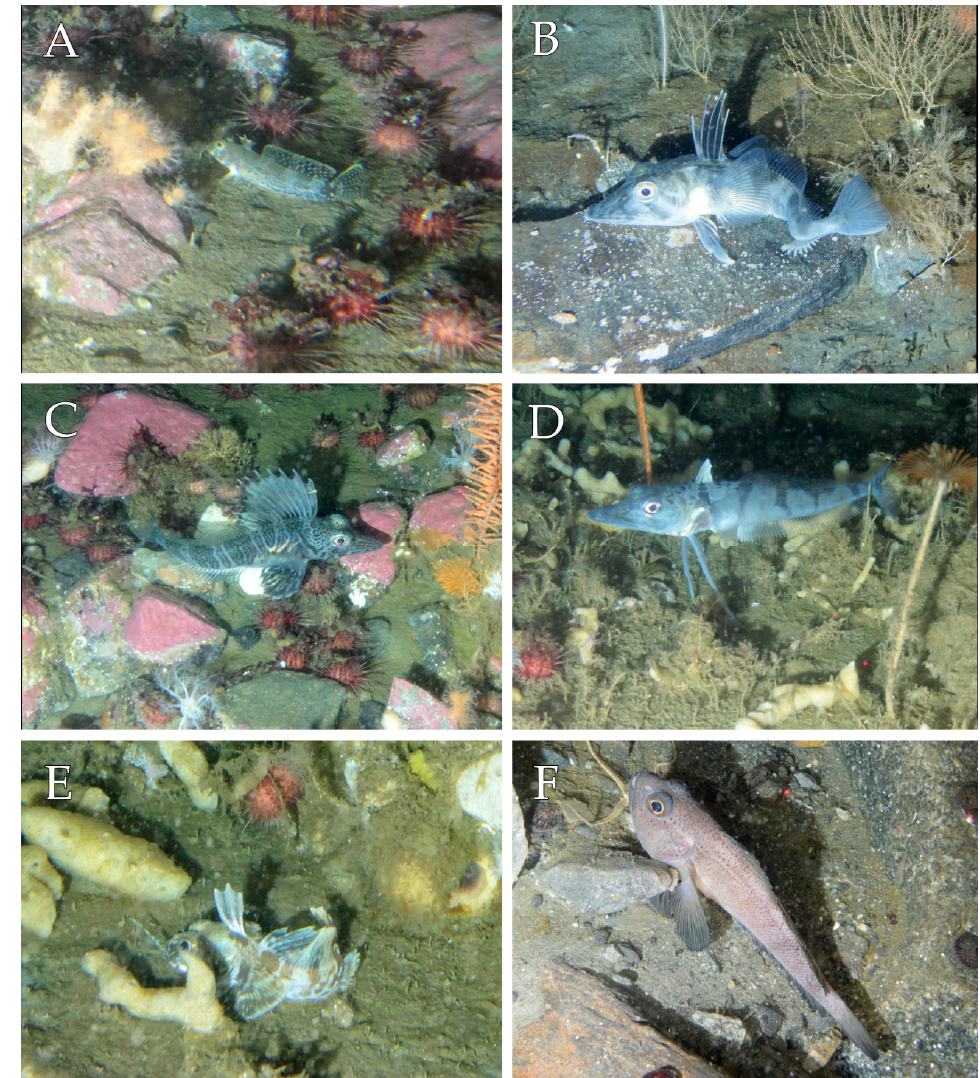
Figure 5. Underwater photographic pictures of the notothenioid fishes recorded during the ROV survey in inshore waters of Terra Nova Bay. ( A ) Artedidraco skottsbergi ; ( B ) Chionodraco hamatus ; ( C ) Pagetopsis macropterus ; ( D ) Cryodraco atkinsoni ; ( E ) Histiodraco velifer ; ( F ) Trematomus nicolai .